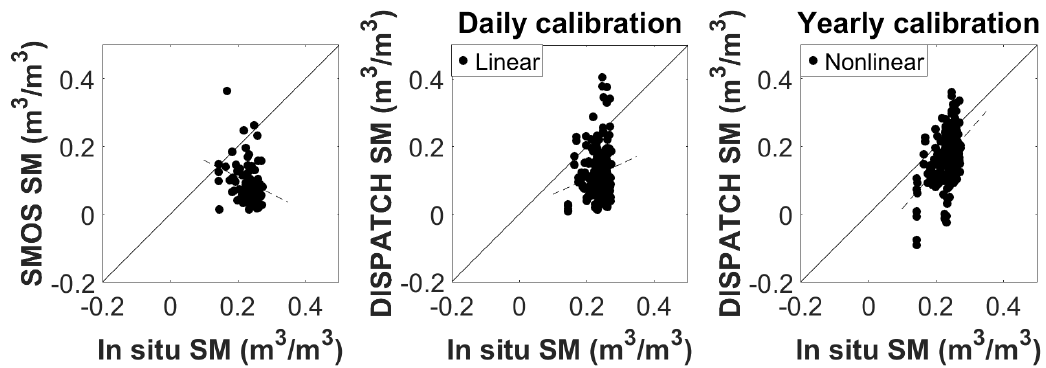
Figure 8. The SMOS and DISPATCH SM are plotted against measurements collected from sensors over the Algerri-Balaguer